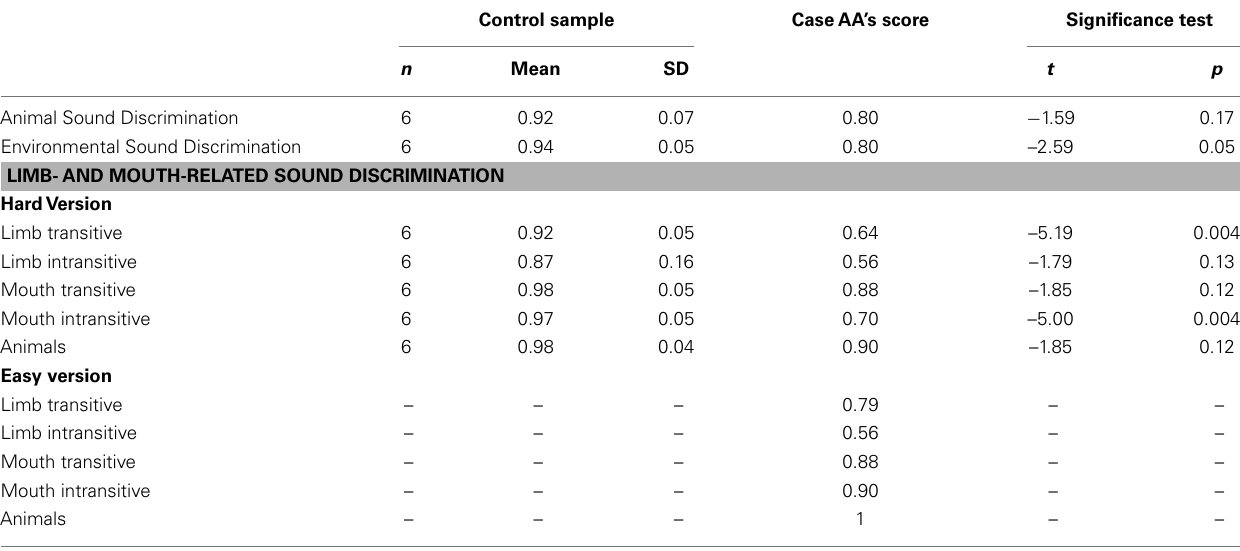
Table 7 | Semantic knowledge tested from non-linguistic auditory stimuli.